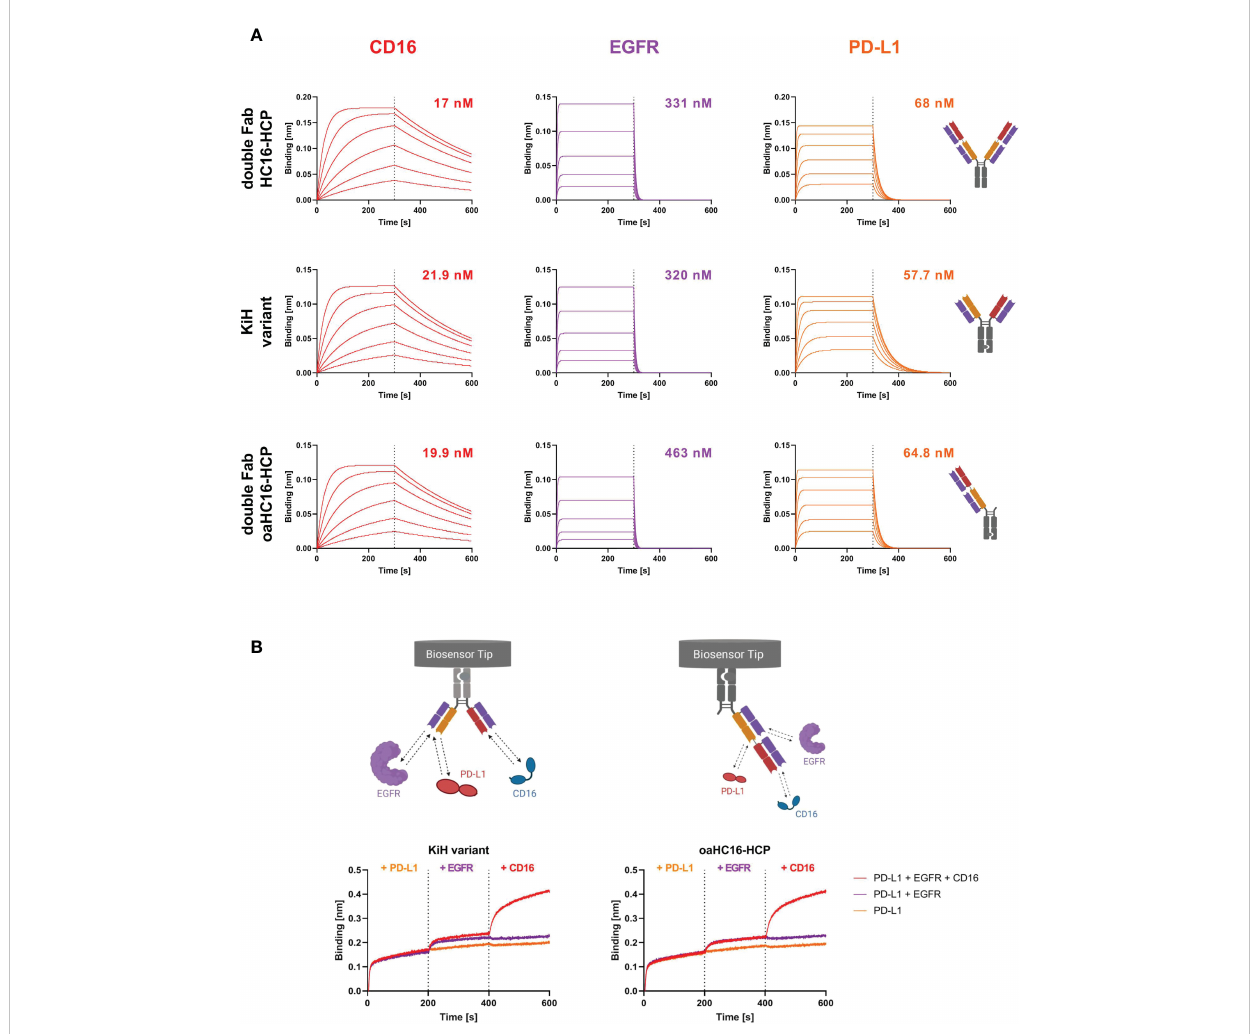
FIGURE 2 Characterization of antigen binding of the trispeci fi c antibody variants by BLI-measurements. (A) BLI-measurements of the double Fab variant HC16- HCP, the knob-into-hole (KiH) variant and the one-armed (oa) double Fab variant oaHC16-HCP against CD16a, EGFR and PD-L1. All antibody variants target the three respective antigens with comparable K D values. (B) BLI-assisted simultaneous binding assay. The KiH variant and the oa double Fab variant were loaded onto AHC biosensors and antigens were added stepwise, demonstrating simultaneous PD-L1, EGFR and CD16a binding. Created with